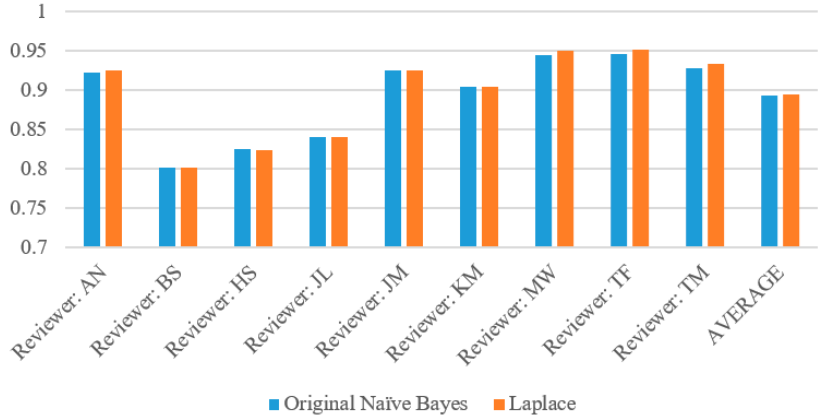
Figure 8. Specificity for each reviewer with both original Naïve Bayes and Laplace.